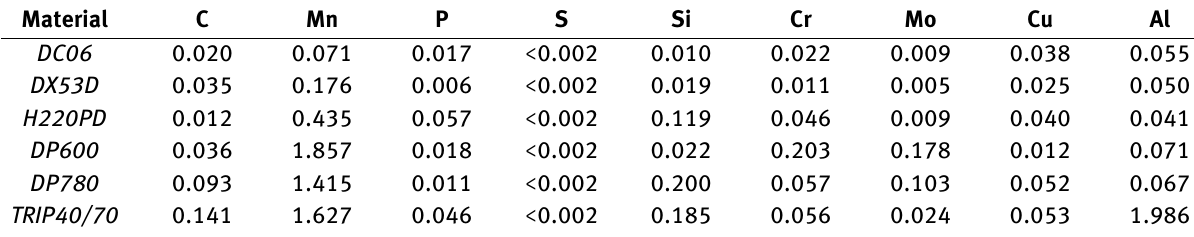
Table 2: Chemical composition of joined materials (wt.%).